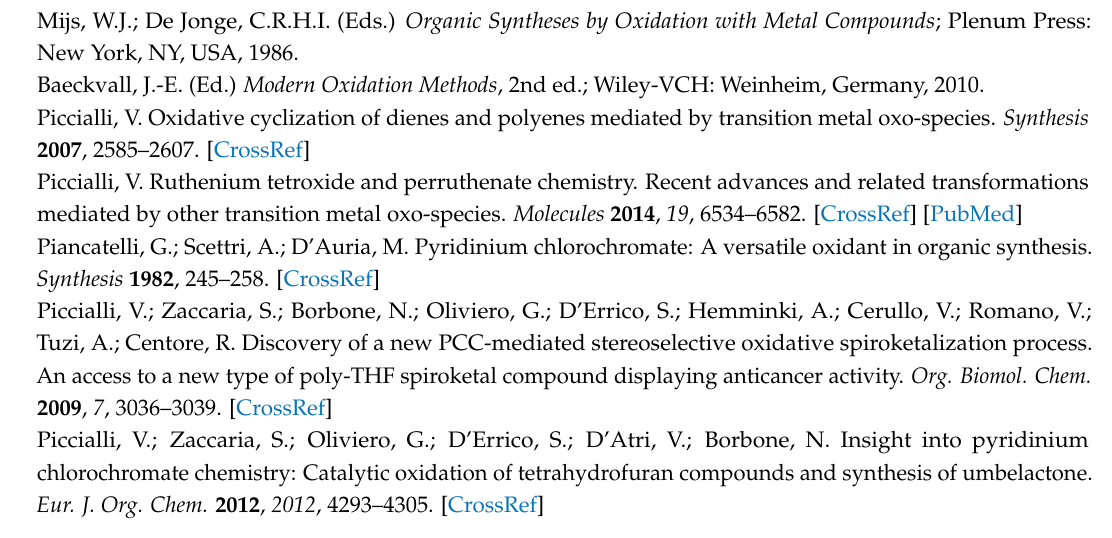
Figure S2: 13 C-NMR spectrum of 2 , Figure S3: 1 H-NMR spectrum of 3 , Figure S4: 13 C-NMR spectrum of 3 , Figure S5: EIMS spectrum of 3 , Figure S6: HRESIMS spectrum of 3 , Figure S7: FTIR spectrum of 3